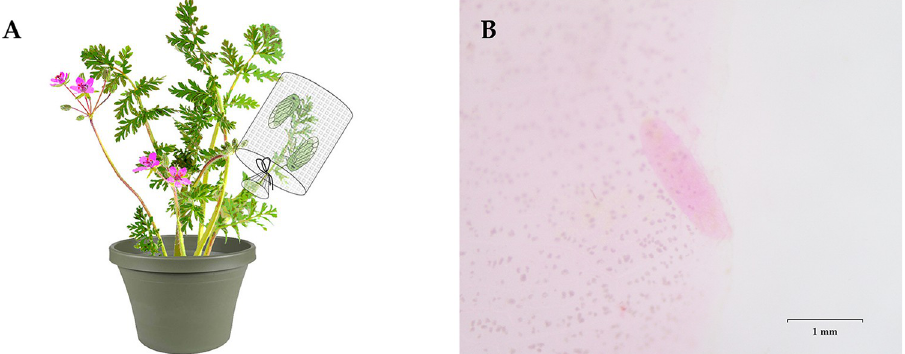
Fig 1. Diagrammatic illustration of the experimental design (A). A beet leafhopper egg laid in a sugar beet leaf stained with McBryde’s solution